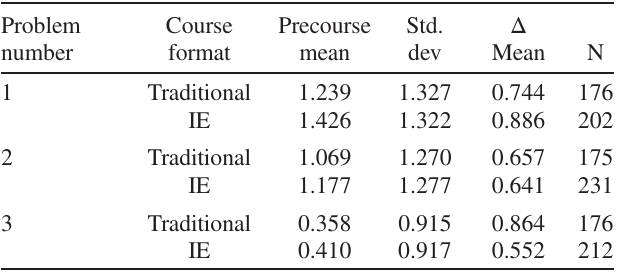
TABLE III. Precourse coherence scores (and standard devia- tions) and increase in postcourse coherence scores for sample of IE physics students matched to the traditional physics students on the precourse coherence scores. ( Δ Mean indicates the average of the difference between each student ’ s pre- and postcourse score.)